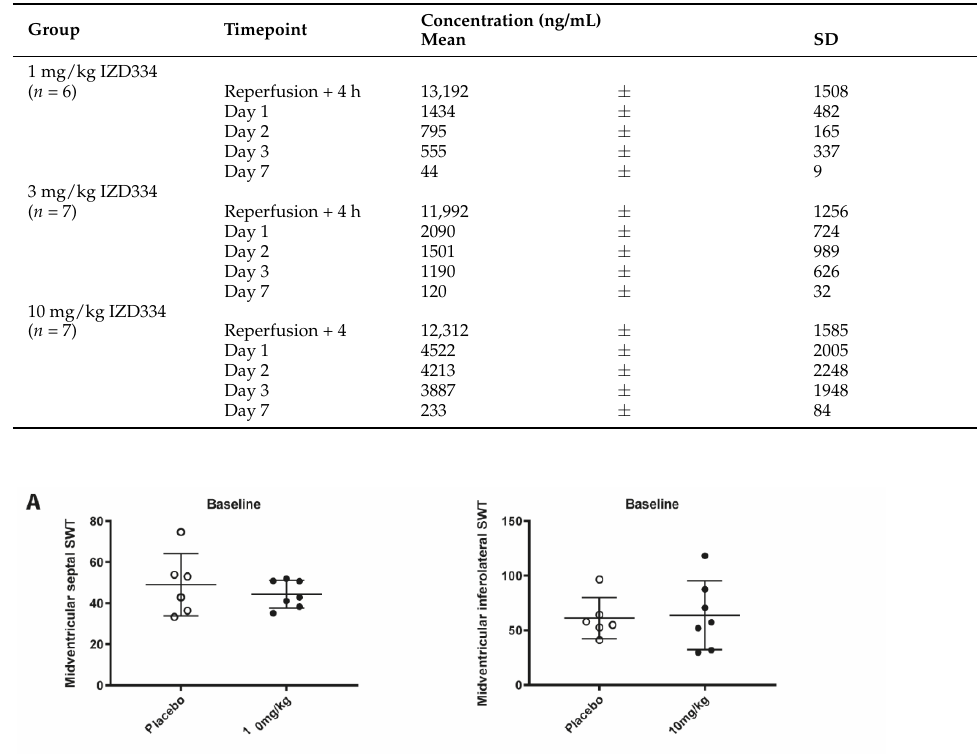
Table A3. Plasma levels of IZD334 in vivo.